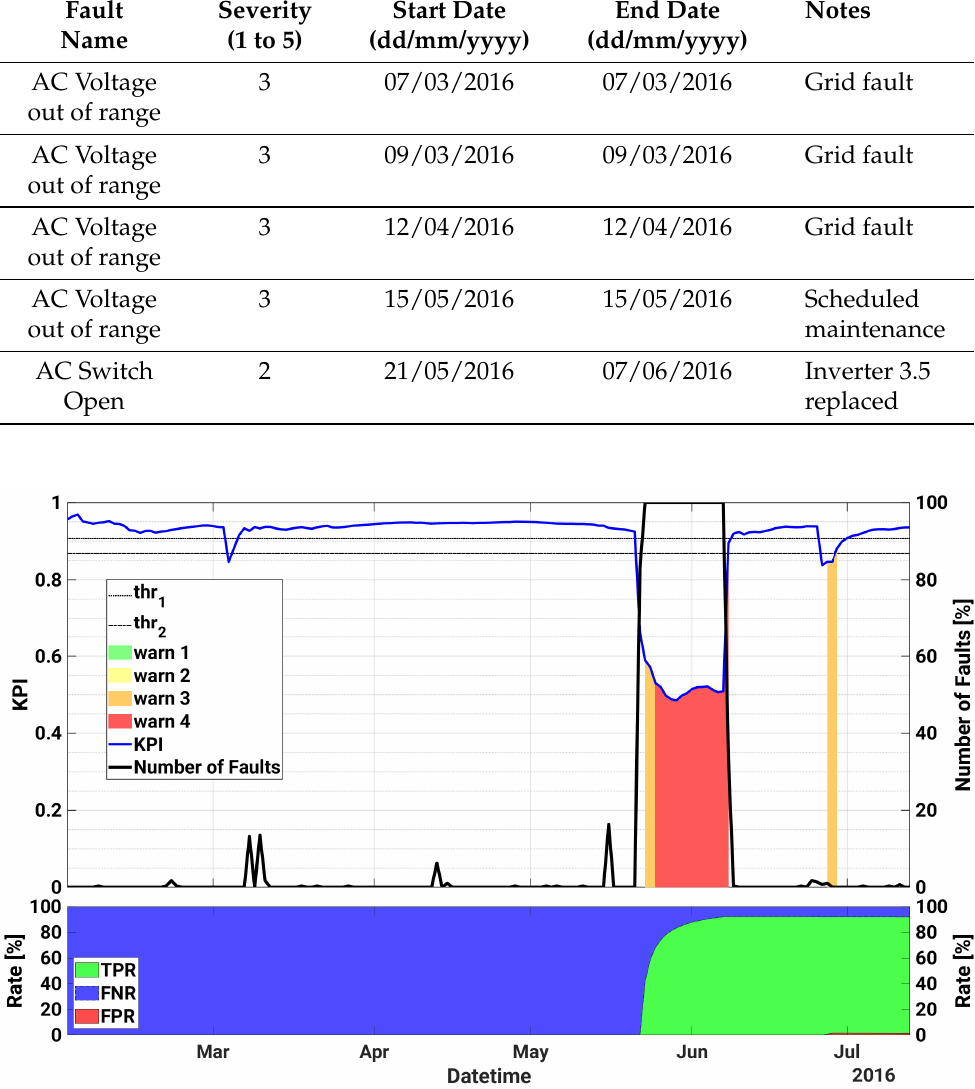
Figure 7. Historical case studies for inverter 3.5 of plant C. Top plot—Left axis: KPI, as well as the warning levels and the upper and lower thresholds are shown as a function of datetime; Right axis: time series of daily number of faults. Bottom plot: TPR, FNR and FPR as a function of